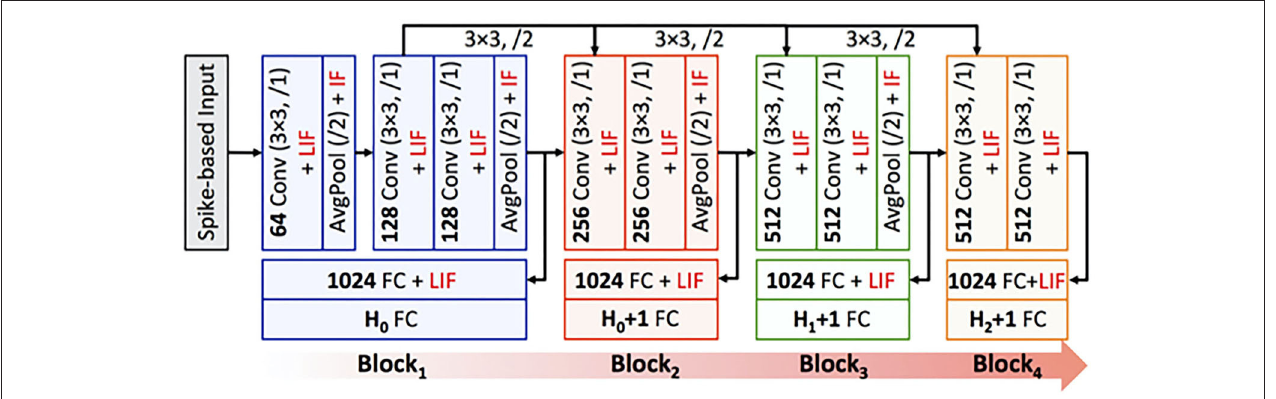
FIGURE 3 | ResNet-11 spiking neural network (SNN), similar to the end-to-end topology presented in Lee et al. (2020), used to validate BlocTrain. The first 3 blocks make up ResNet-9 SNN. Block 1 is trained on all the classes ( H 0 ). Any other block i is trained on the hard classes of block i − 2 ( H i − 2 ), and has an additional hard class detector (HCD) binary unit. The number of output feature maps, kernel size, stride, and spiking nonlinearity are specified for all the layers in each block of the ResNet SNN analyzed in this